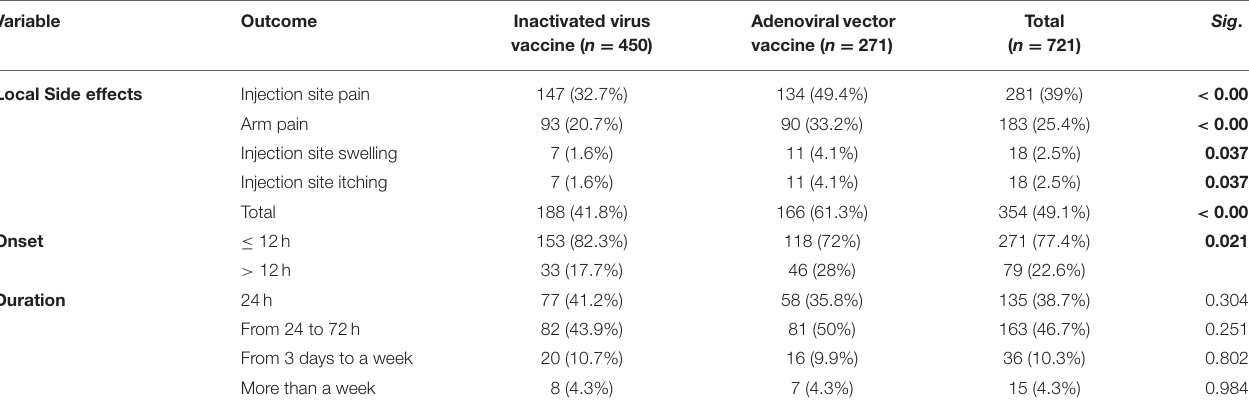
TABLE 3 | Local side effects reported by Algerian healthcare workers receiving COVID-19 vaccines ( n =